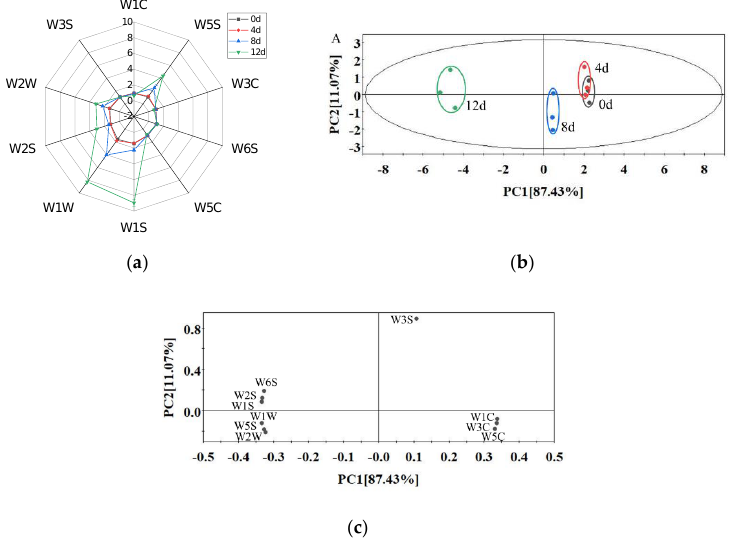
Figure 5. Radar chart ( a ) and PCA score plot ( b ) and loading plot ( c ) from the E-nose data of vac- uum-packaged peeled potato samples during storage. A principal component analysis (PCA) was used to analyze the differences of the flavor profiles of samples from different storage periods (Figure 5b). PC1 and PC2 ex- plained 87.43% and 11.07% of the total variance, respectively. The cumulative variance contribution rate of the first two principal components reached 98.5%, which explained a large fraction of the overall variability. As the storage period was prolonged, the distance of day 4 – 12 from day 0 became longer. The PCA profile of day 4 almost overlapped with day 0, while those of day 8 and day 12 were clearly separated from day 0 – 4, indicating that the flavor quality deteriorated significantly after 8 days of storage and that the e-nose could be used to discriminate the freshness of peeled potatoes. Furthermore, the off-odor may be caused by spoilage bacteria ( Enterobacteriaceae , Erwinia , Leuconostoc and Lactococ- cus ) due to fermenting sugar [24,28,44].